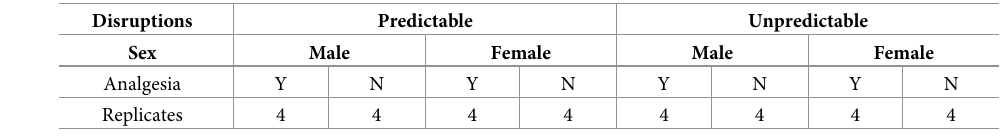
Table 1. Experimental factorial